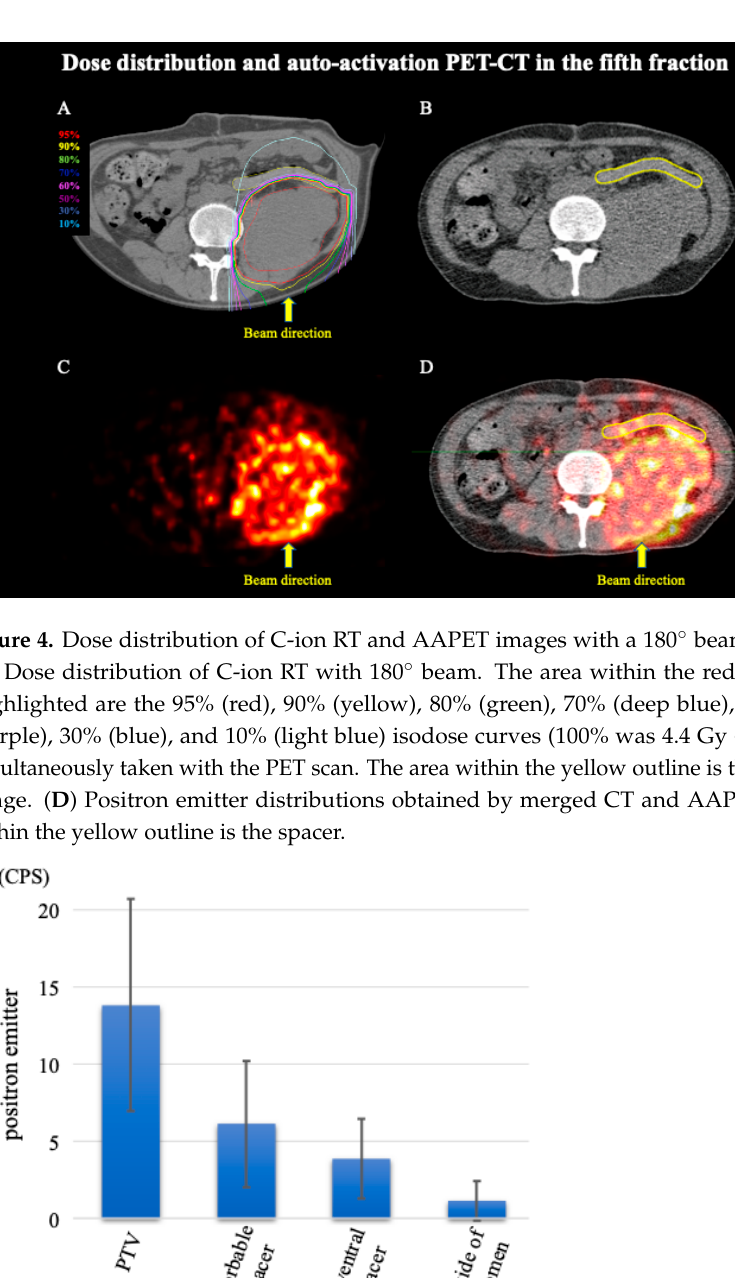
( A ) Dose distribution of C-ion RT with 180° beam. The area within the red outline is the tumor. Highlighted are the 95% (red), 90% (yellow), 80% (green), 70% (deep blue), 60% (magenta), 50% (purple), 30% (blue), and 10% (light blue) isodose curves (100% was 4.4 Gy (RBE)). ( B ) CT image simultaneously taken with the PET scan. The area within the yellow outline is the spacer. ( C ) AAPET image. ( D ) Positron emitter distributions obtained using merged CT and AAPET images. The area within the yellow outline is the spacer.